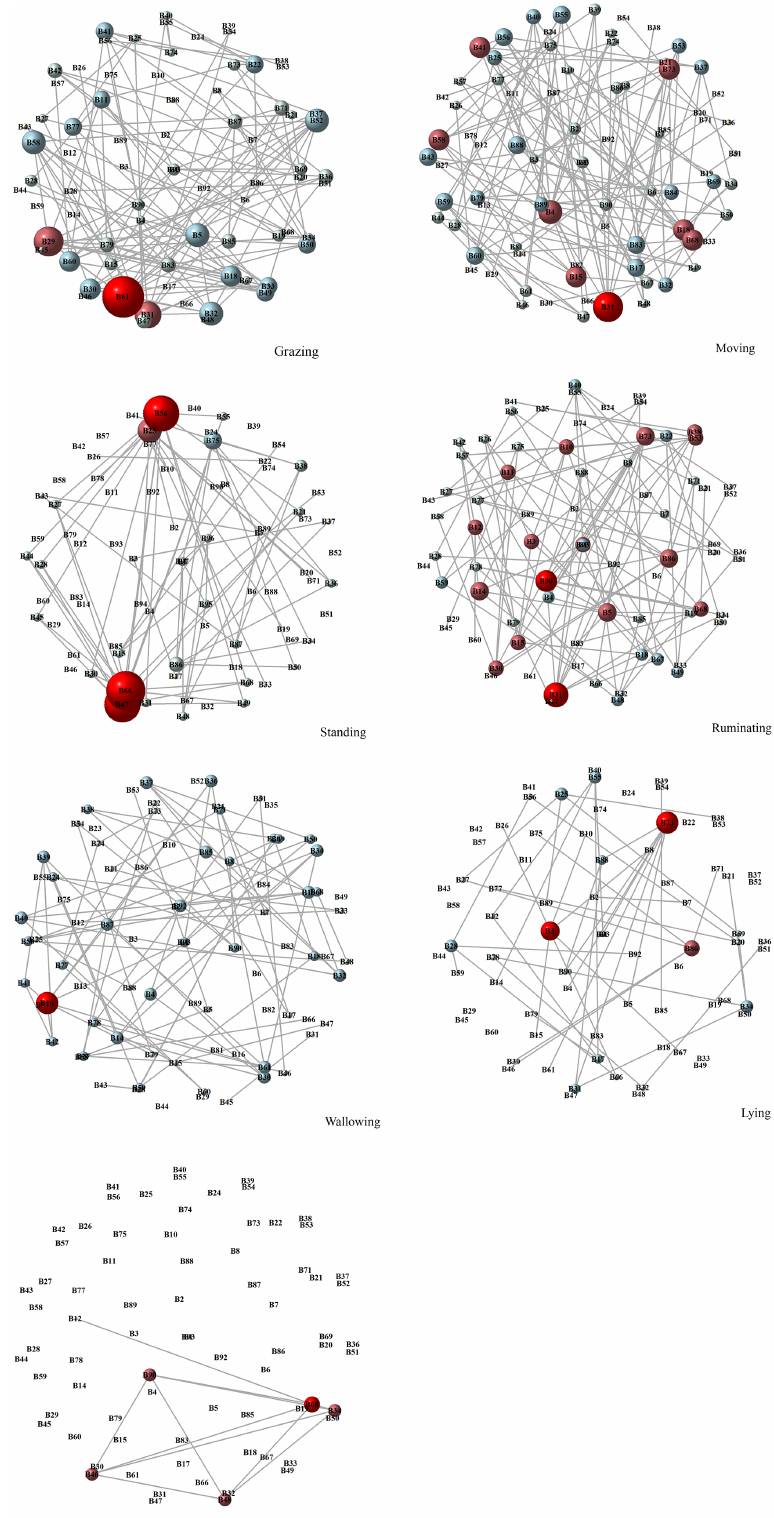
Figure 1. Water buffaloes’ networks during their activities on pasture (grazing, moving, standing, ruminating, wallowing, lying, and drink- ing). The grey lines represent the edges and the circles represent the vertices of the network. An edge corresponds to the proximity between two water buffaloes. The size and color of the vertices were based on degree centrality values. Bigger and redder vertices have higher degrees, while smaller and more grey vertices have smaller degrees. The vertices’ label is their identification